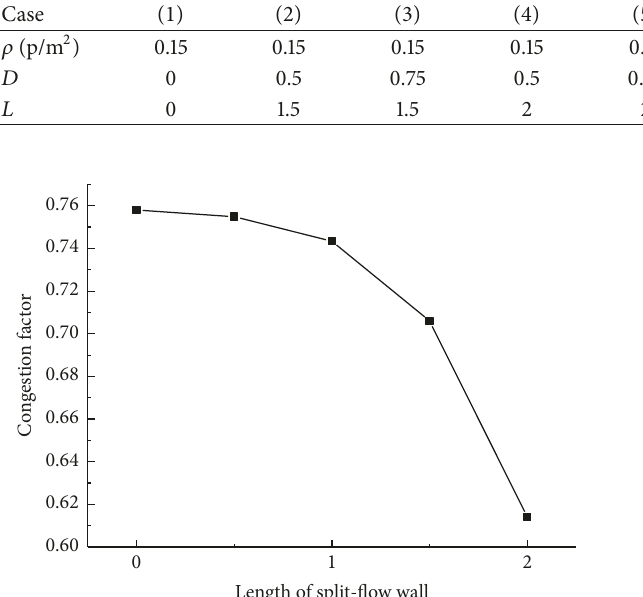
Figure 9: Congestion factor when 𝐷 = 0.5 , 𝜌 = 0.5 .